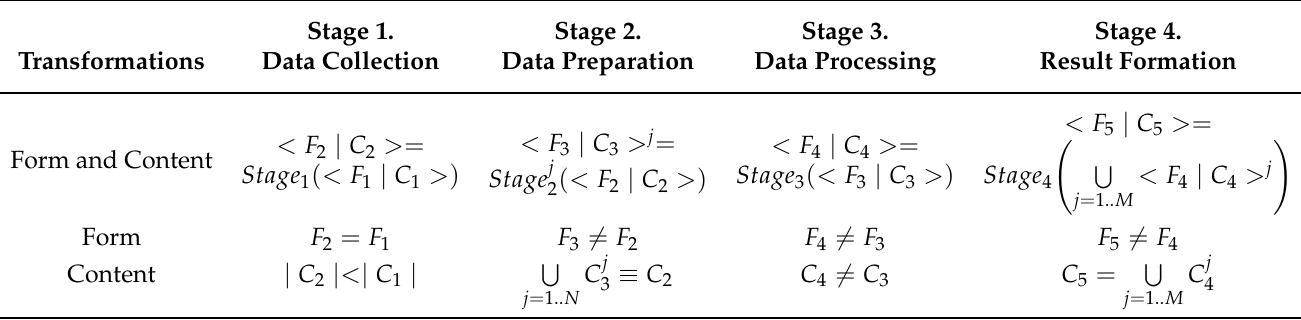
Table 1. Form and Content transformations in the process of static analysis of the information